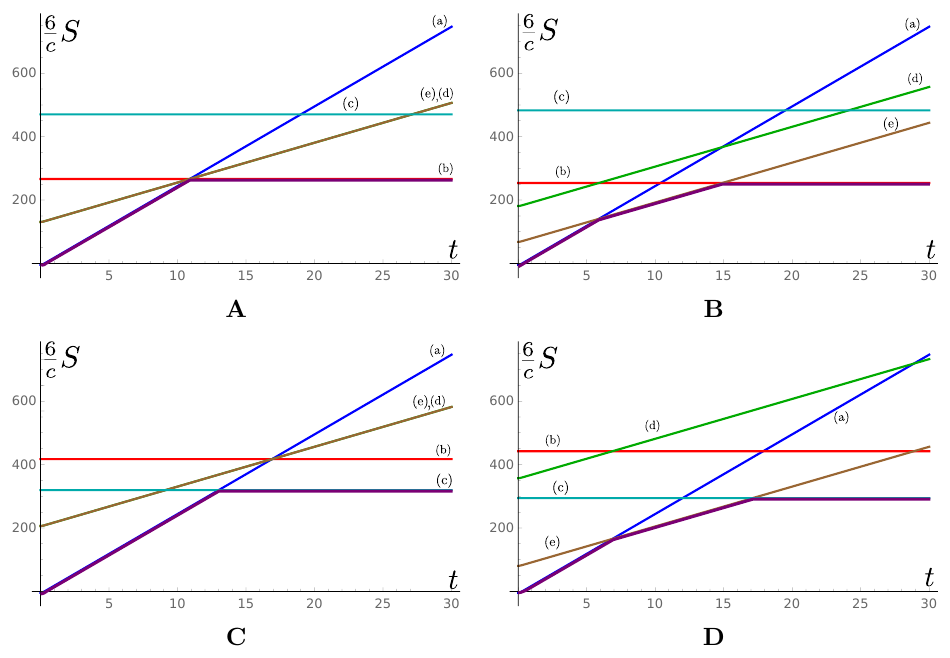
Figure 14. Page curves for the radiation segments in the reservoir in the equal temperature case with β = β = 1 . (A) a = 0 . 12 L , b = 0 . 88 L . (B) a = 0 . 02 L , b = 0 . 78 L . (C) a = 0 . 24 L , b = 0 . 76 L 1 2